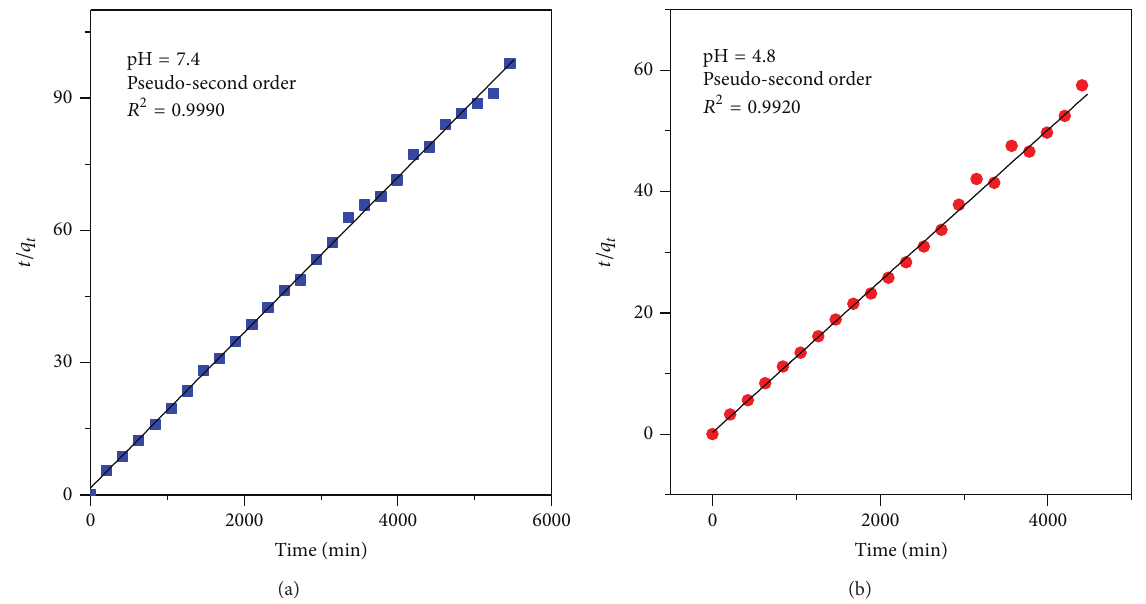
Figure 7: Fitting the data of MP release from FPEGMP-2 nanocomposite into phosphate buffered solution to the pseudo-second order kinetics for pH 7.4 (a) and pH 4.8 (b).